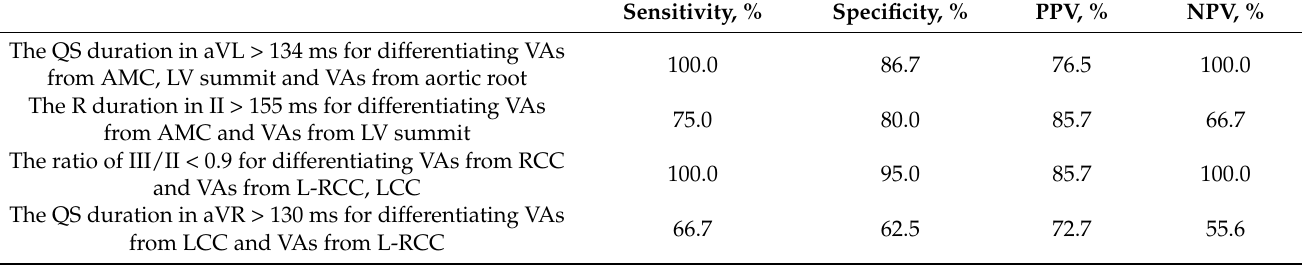
Table 4. The accuracy of ECG algorithm for predicting the origins of VAs from LVOT in prospective cohort. Sensitivity, %